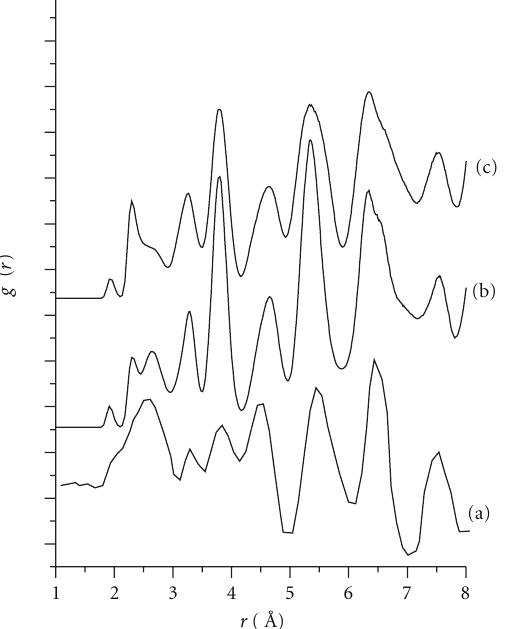
Figure 5: Radial distribution functions from experimental (a) and molecular dynamics simulations (b and c); La 0 . 3 Eu 0 . 7 AlO 3 (a), La 0 . 3 Eu 0 . 7 AlO 3 (b), and La 0 . 1 Eu 0 . 9 AlO 3